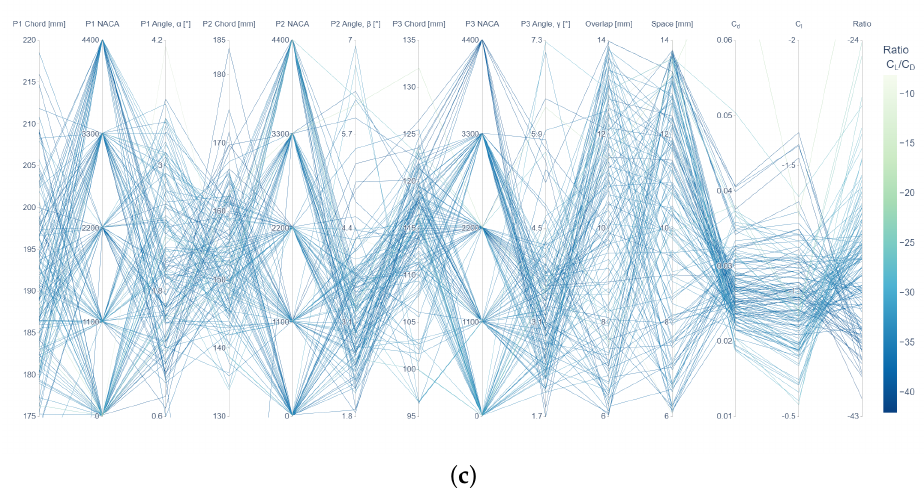
Figure 6. Parameter exploration via Parallel Coordinate Plot for ( a ) https://plotly.com/pablomh/16/, A-A cross-section (400 mm), ( b ) https://plotly.com/pablomh/18/, B-B cross-section (670 mm), and ( c ) https://plotly.com/pablomh/20/, C-C cross-section (940 mm), of the five-element front wings from the specified input design variable ranges. Please note that hyperlinks to Plotly graphs are included in the electronic version of this paper for interactive visualisation of the